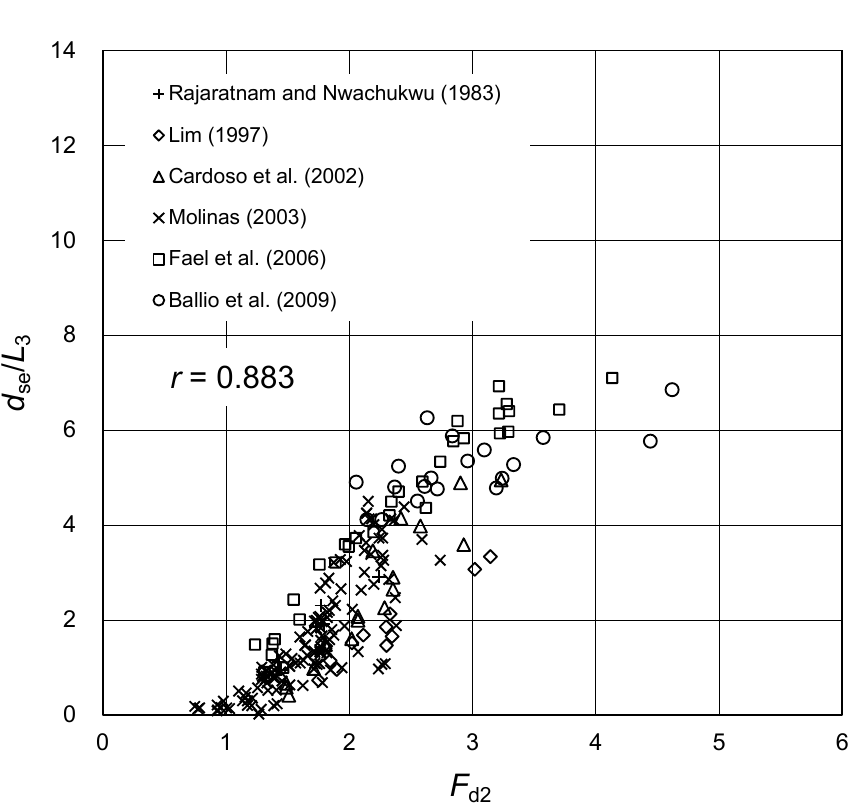
(cid:16) (cid:17) − 1 1 + 1 b h (cid:2869) (cid:2869) = (cid:4672) + (cid:4673) ]. [ (cid:1838) (cid:3031)(cid:2870) (cid:2871) (cid:3029) (cid:3035)